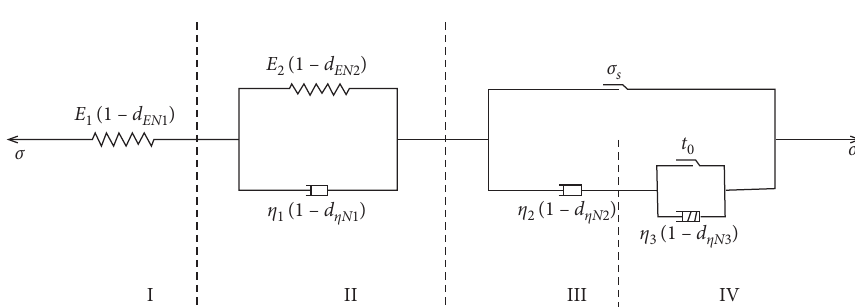
Figure 4: Constitutive model for a sandstone rock (considering the effect of